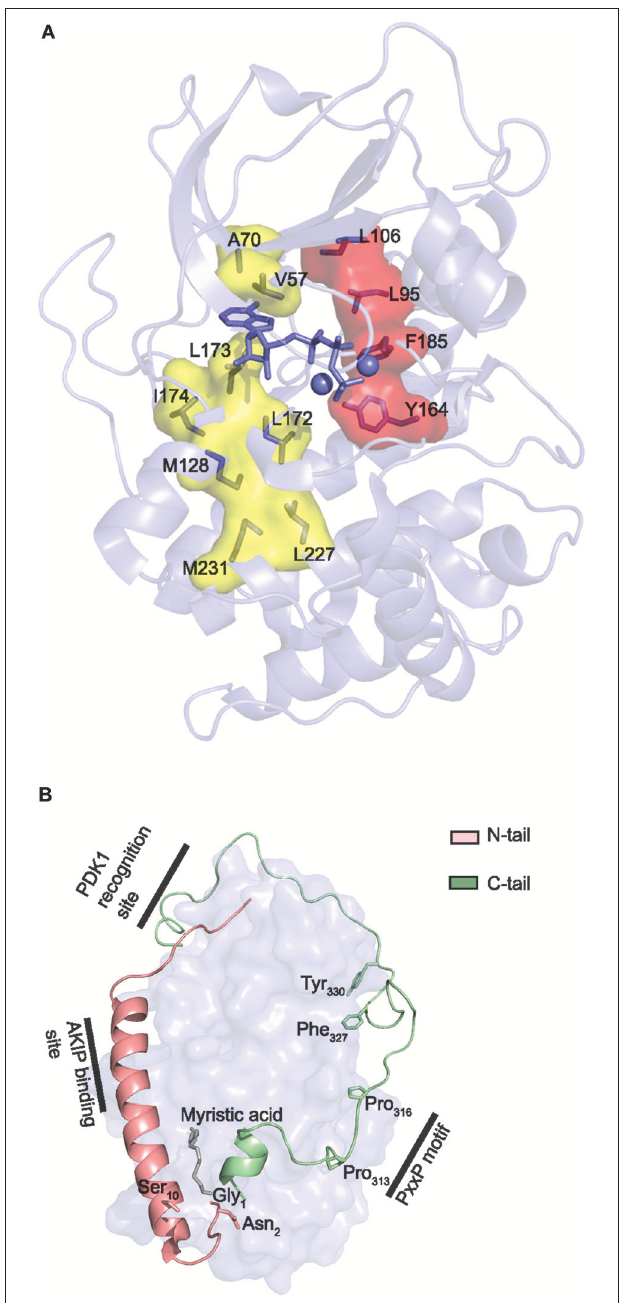
FIGURE 4 | Core and tail structures of the PKA C subunit. (A) C- and R-spines in C α 1. In the active conformation of kinases, the C- and R-spines are assembled. In the case of PKA C α 1, the residues constituting the C-spine (yellow) are Ala70, Val57, Leu173, Ile174, Leu172, Met128, Met231, and Leu227. The adenine nucleobase of ATP (slate stick presentation) is also part of the C-spine. The R-spine (red) consists of C α 1 residues Leu106, Leu95, Phe185, and Tyr164. One-letter aa abbreviations are used in the figure. Figure is based upon (175). PDB identifier 3FJQ (169). (B) Presentation of the conserved kinase core (rendered as a surface in slate) of C α 1, including the N-tail (salmon) and C-tail (green) in cartoon presentations. Myristic acid (gray) is shown bound to the hydrophobic pocket. Selected structures and residues in the N- and C-tails are highlighted and described in the text. PDB identifier 1CMK